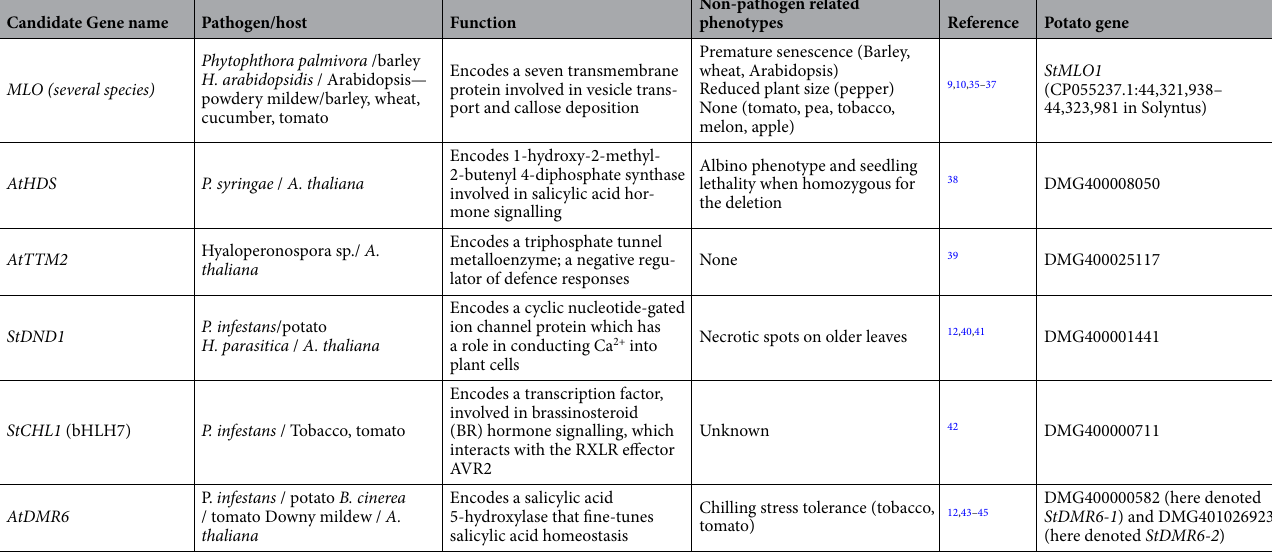
Table 1. Selected putative S-genes in